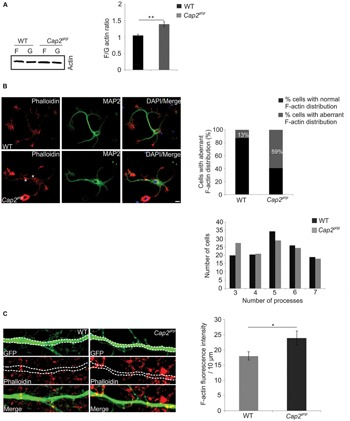
CAP2 deletion leads to actin accumulation and impaired actin dynamics. (A) Immunoblotting of WT and CAP2 mutant brain lysate for determination of the F/G-actin ratio revealed an increase in F-actin in mutant brain lysate (WT: 1.06 ± 0.03, n = 4 mice; Cap2gt/gt: 1.3 ± 0.1, n = 4 mice, p < 0.01). (B) Immunocytochemistry of cultured cortical neurons after 24 h in cultures demonstrated F-actin accumulation in the soma and in neuritic processes of mutant neurons (white asteriks). F-actin was visualized with phalloidin staining. Scale bar, 10 μm. Quantification of WT and mutant neurons showing aberrant F-actin distribution in the soma and/or neuritic processes. Quantification of dendritic processes. The distribution of cells with a certain number of processes is shown. (C) pEGFP-C2 transfected neurons labeled with TRITC-phallodin at div 16. Quantification revealed a significant increase in F-actin intensity in the dendritic shaft (white dashed line; WT: 18.0 ± 1.3 F-actin intensity (AU)/10 μm; Cap2gt/gt: 24.0 ± 2.3 F-actin intensity (AU)/10 μm, n = 20 neurons from 3 experiments, p < 0.05). Scale bar, 5 μm. AU, arbitrary unit; *p < 0.05, **p < 0.01.